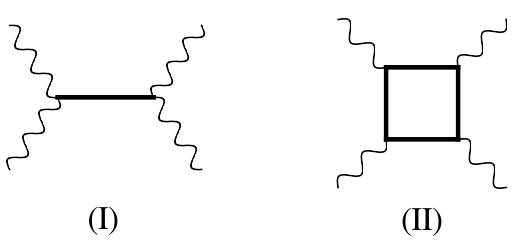
Figure 1 . Different origins for the EFT: (I) Integrating away massive states in tree exchanges, for example the Higgs for the Sigma model and the infinite tower of higher spin states in string amplitudes, (II) or massive states in the loop, for example the ϕX 2